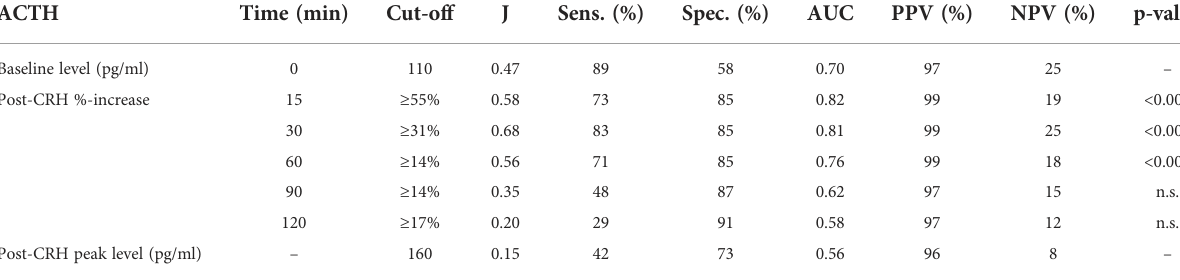
TABLE 2 Diagnostic outcome of ACTH during the CRH stimulation